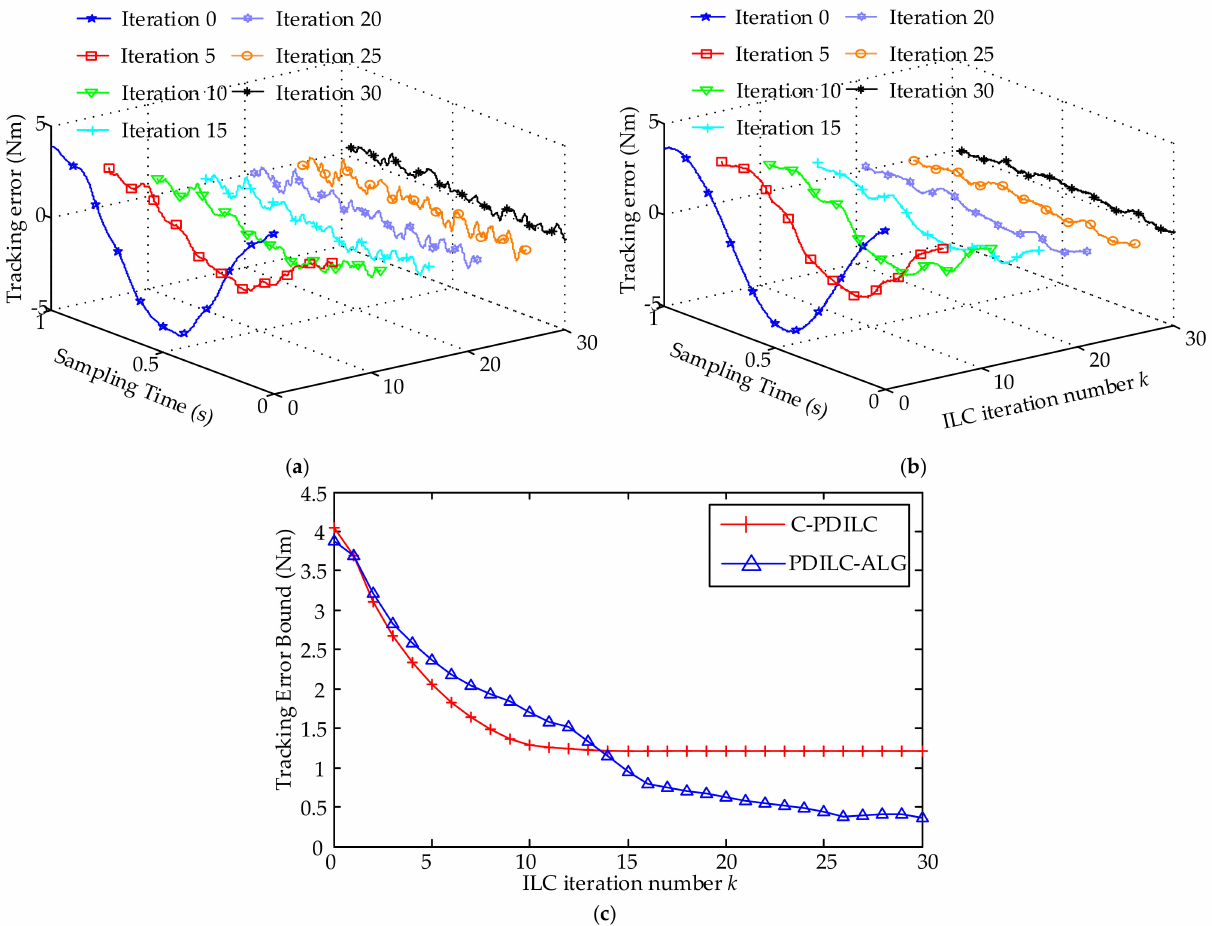
Figure 6. Case 1 experimental results ( θ ∗ a ( t ) = 8 ◦ sin ( 2 π ih ) , y d ( t ) = 30sin ( 2 π ih ) ): ( a ) Loading torque tracking errors at different iterations of the conventional PD-type iterative learning control. ( b ) Loading torque tracking errors at different iterations of the proposed PD-type iterative learning control with adaptive learning gains. ( c ) The error bound comparisons of loading torque tracking for 30